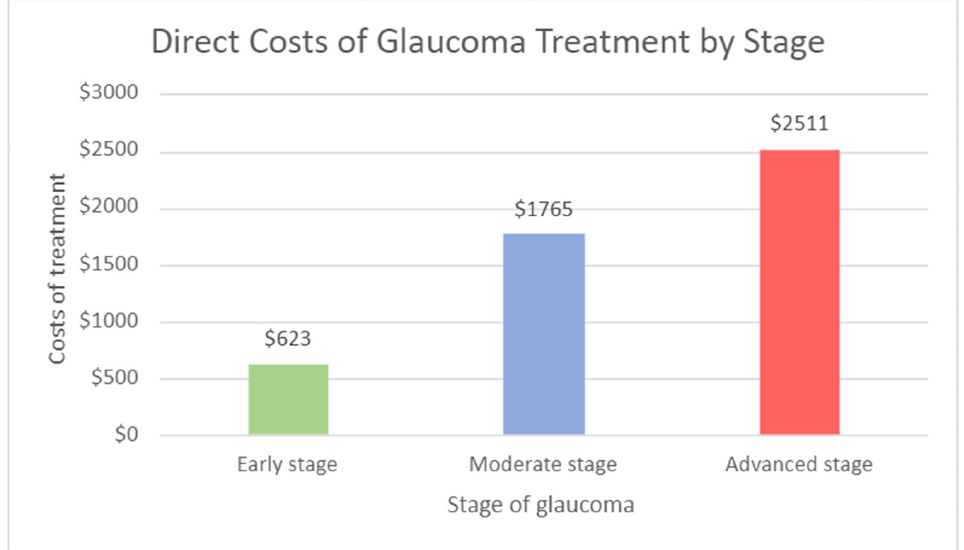
Figure 7. Direct cost of glaucoma treatment by stage.